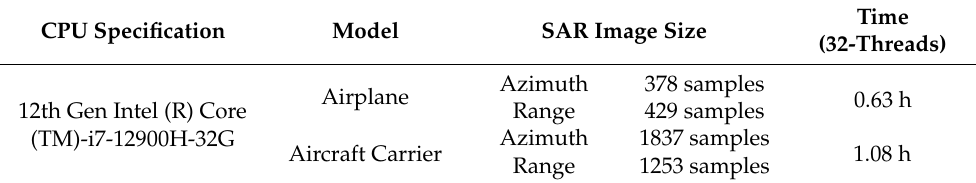
Table 4. Computing environment and time consumption.